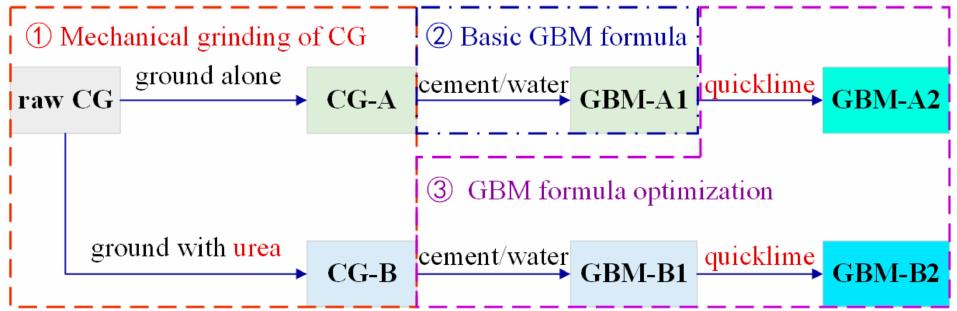
Figure 1. Research process of CG-based grouting backfill